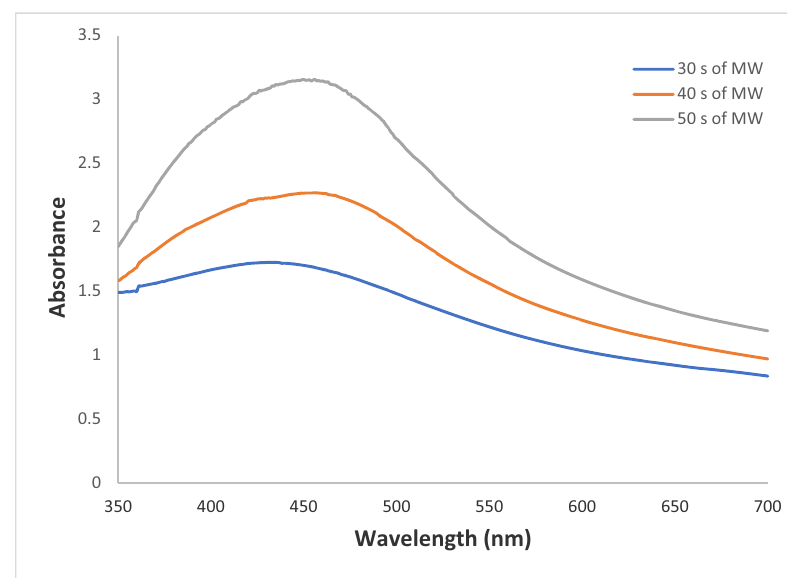
Figure 4: UV – Vis spectra of synthesized AgNPs with 1 g · L − 1 of AgNO 3 at di ff erent times of microwave